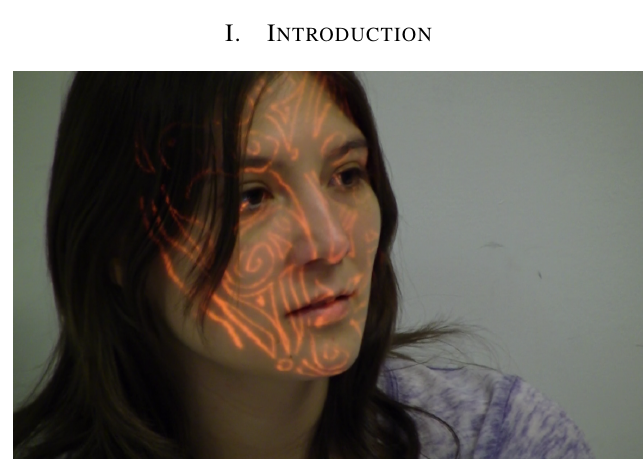
Fig. 1. A tattoo-like pattern projected on a